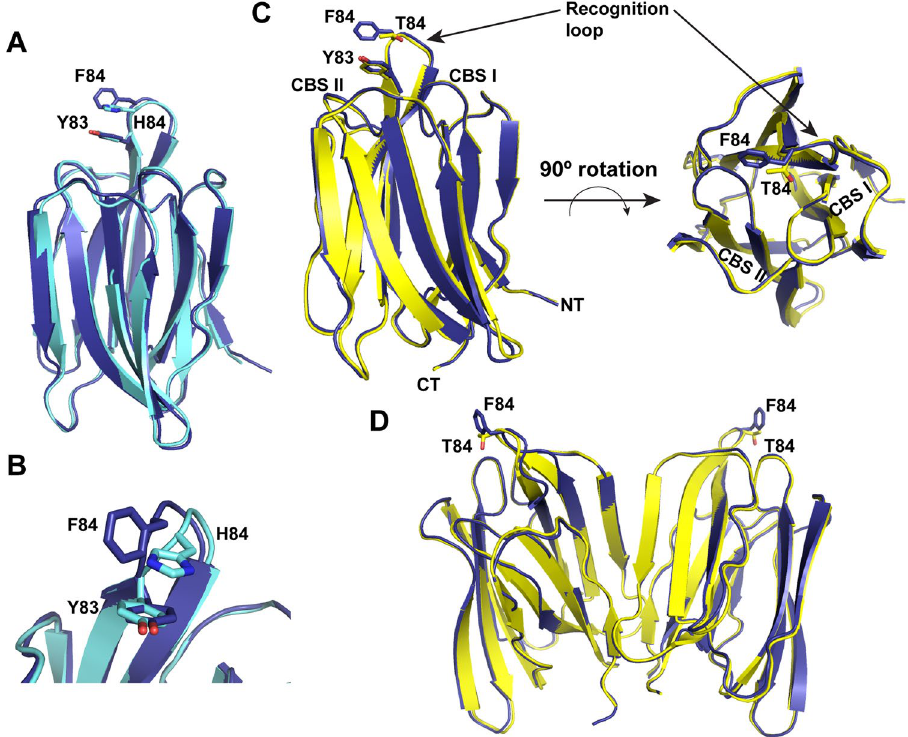
Figure 6. The F84T mutation interrupts pi–pi stacking between Y83 and F84 without altering the overall structure of Malay BanLec. ( a , b ) Crystal structures comparing WT BanLec (cyan) to WT Malay BanLec (navy). H84 in BanLec and F84 in Malay BanLec are indicated. Y83 exists in both structures. In ( a ) the alignment of the monomers is depicted, and in ( b ) a close-up of the ligand binding loops showing the pi–pi stacking interactions between H84 and Y83 and F84 and Y83 in WT BanLec and Malay BanLec, respectively. ( c , d ) Crystal structures comparing WT Malay BanLec (navy) to F84T Malay BanLec (yellow). In ( c ) two views of the alignment of the monomers are depicted. F84 in WT Malay BanLec and T84 in F84T Malay BanLec are indicated, along with the Y83 in common. CBS I and II are also shown, with the ligand binding loop containing the residues of interest in between them. NT N-terminus, CT C-terminus. In ( d ) the alignment of the dimers is depicted. The figure was generated using PyMol v2.3 (https ://pymol .org/2/) and Adobe Illustrator, version 22.1.0 (https ://www.adobe .com/produ cts/illus trato